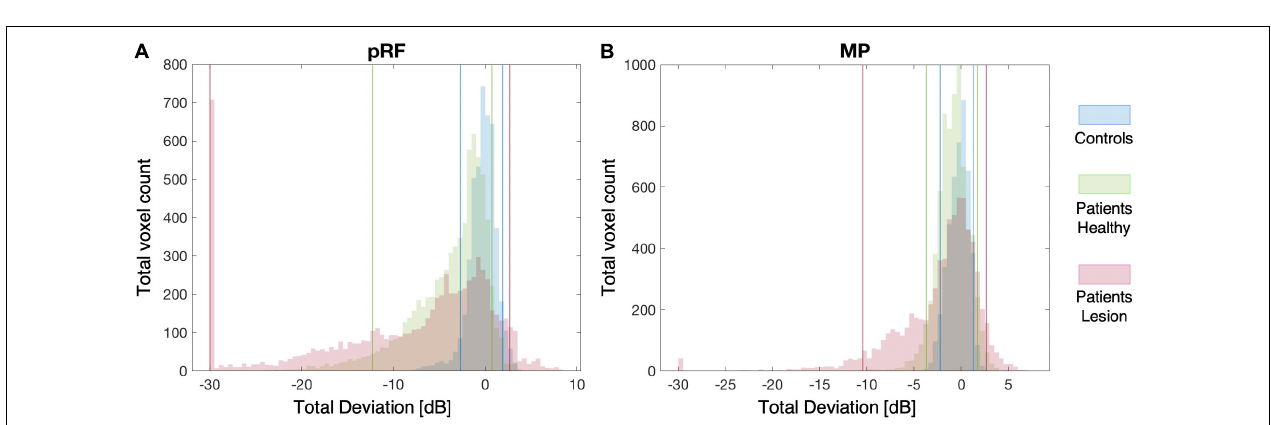
FIGURE 4 | Comparison of the two fMRI-based VF reconstructions with the perimetric VF. Total deviation values are color coded according to the CI intervals of the Total Deviation distributions of the controls where white indicates the deviation to be within normal limits (i.e., the 90% CI) and the gray and green tones below (lower 5%) and above (upper 5%) normal limits, respectively. The zeros (upper) and black squares (lower) in the perimetric plots (panel on the right) indicate the VF locations that are considered blind. The red circle indicates the part of the VF that could be reconstructed with the fMRI-based approaches. Top row: example patient in whom both fMRI-based VF reconstructions show a high degree of correspondence to the perimetric VF plots. Bottom row: example patient with a high correspondence between the pRF-based VF reconstruction and the perimetric VF, while the MP-based VF reconstruction reveals a substantially larger VF coverage.